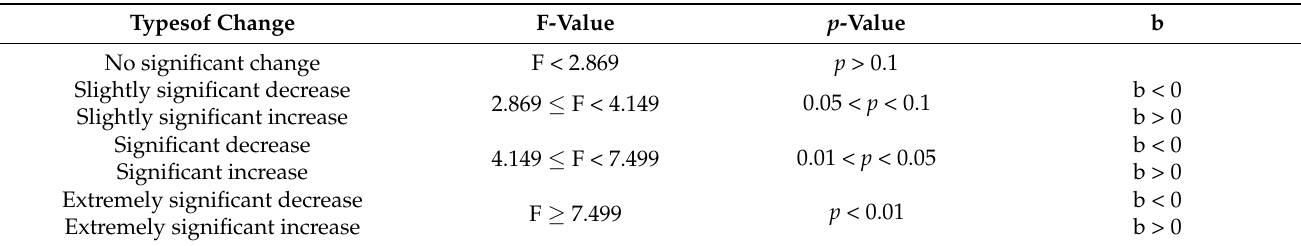
Table 1. Different types of NDVI change trend and significance test (F-value: the significance of F-test; p -value: the significance of linear regression model; b: the slope of linear regression model. When b > 0, the annual NDVI value shows an upward trend; when b < 0, the annual NDVI value shows a downward